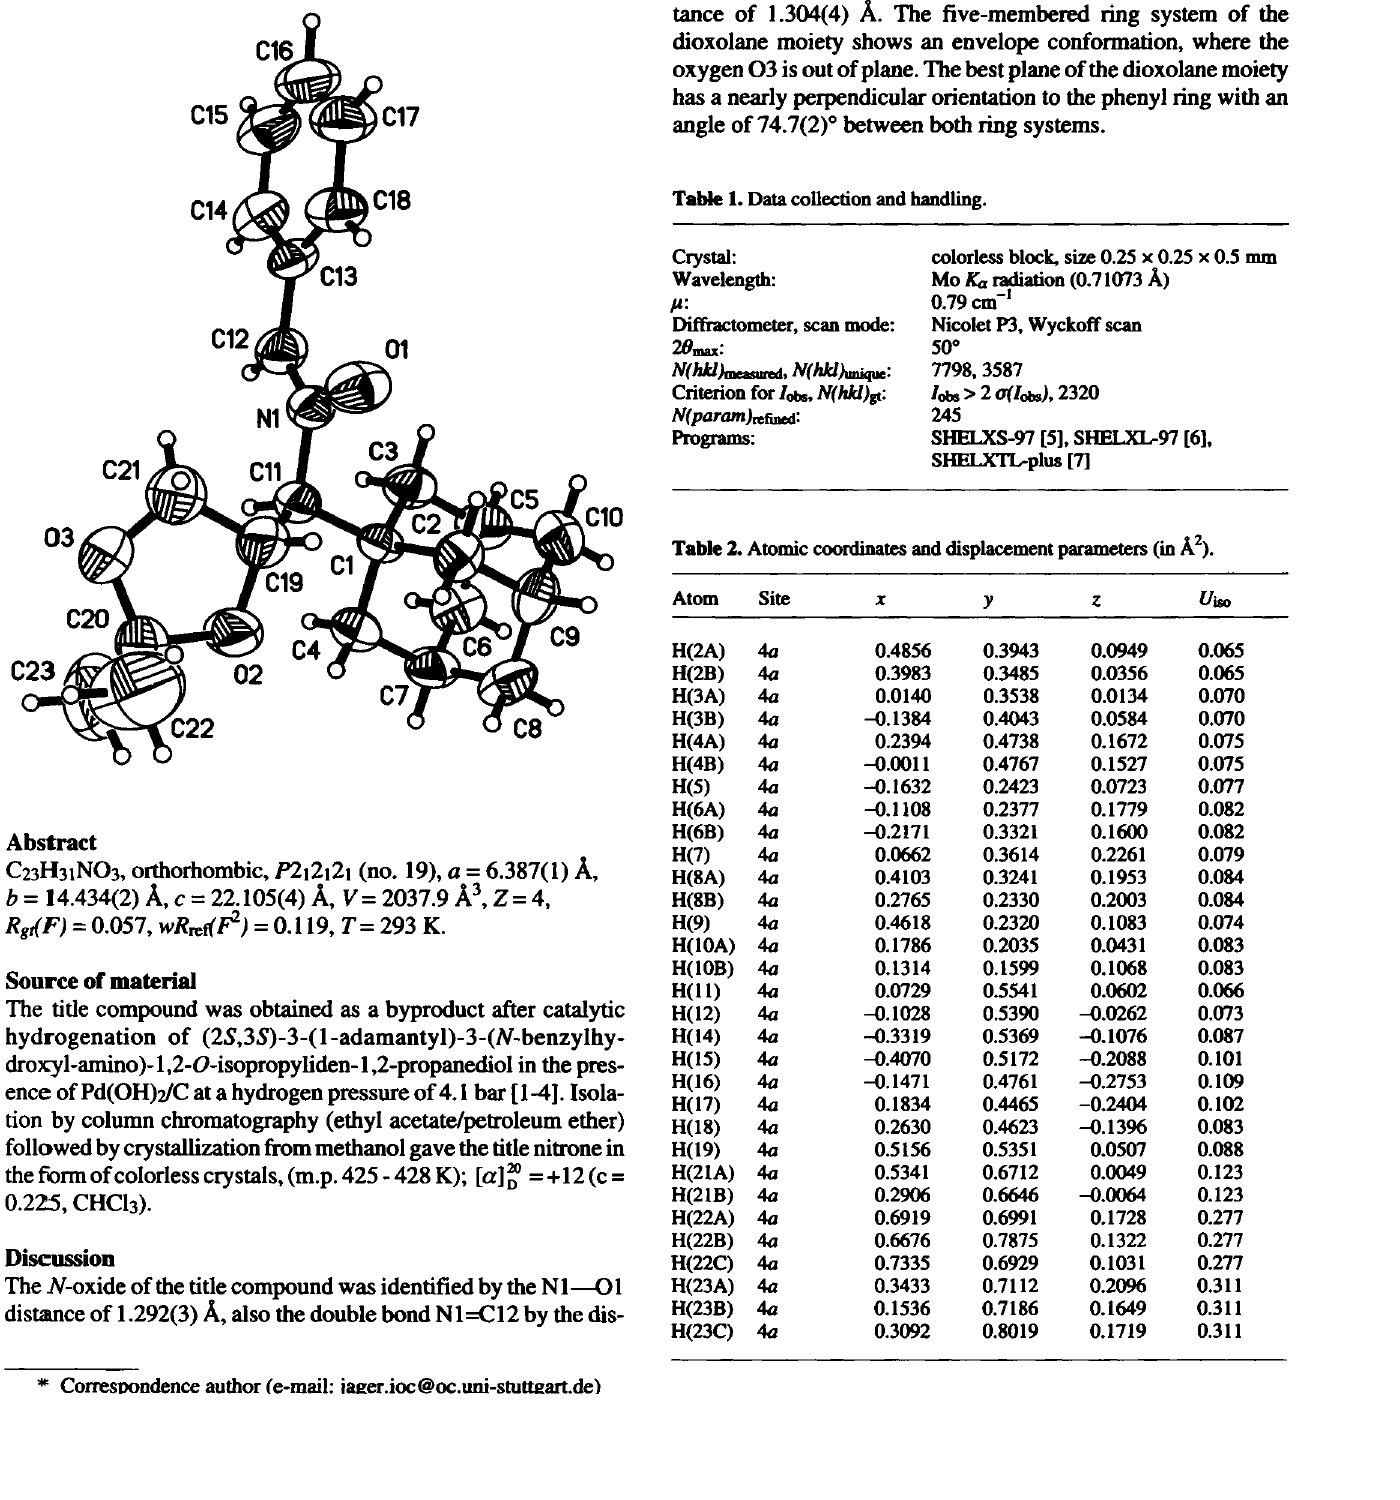
Table 1. Data collection and handling.